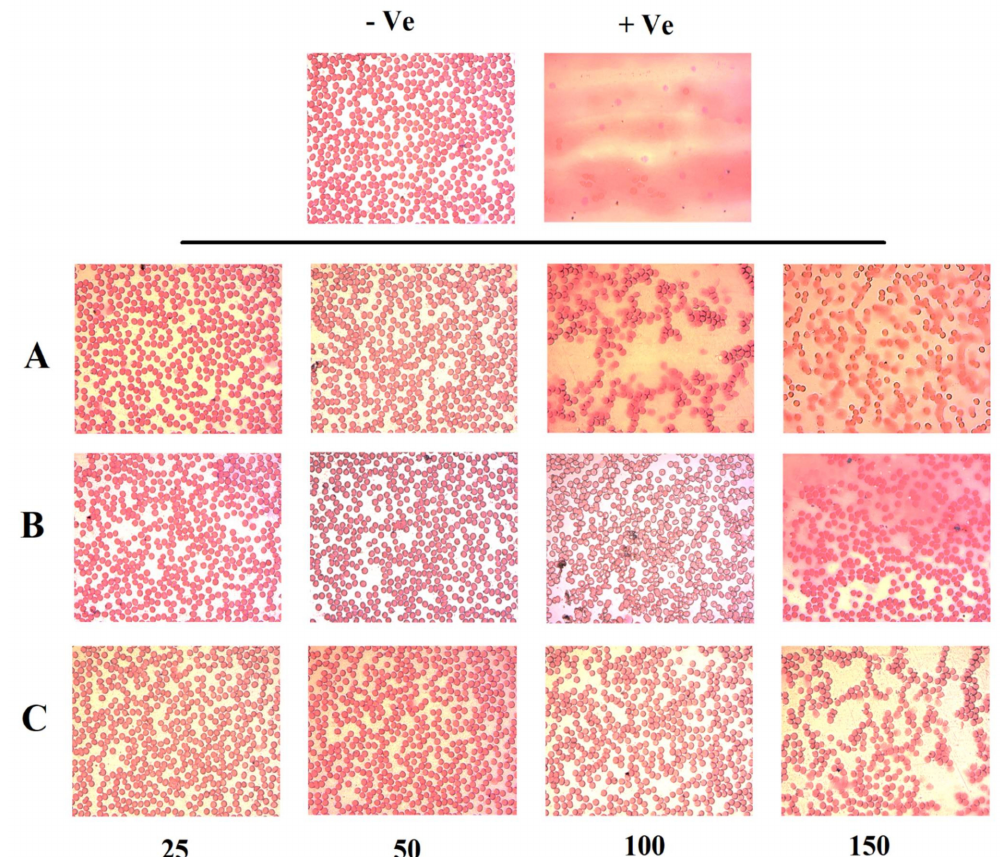
Figure 8. Microscopic images of human RBCs at the same conditions and concentrations: ( A ) TAM, ( B ) RES, ( C ) TAM/RES– LbL-LCNPs. Magnifications is